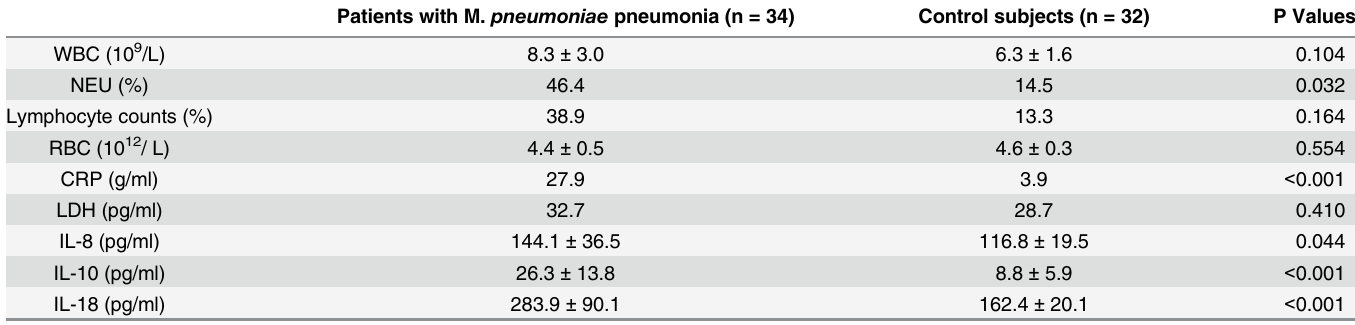
Data on serum IL-8, IL-10, IL-18, WBC, and RBC are presented as means ± SD; Date on Neutrophil counts, CRP levels, LDH levels, and lymphocyte counts are shown with IQR.